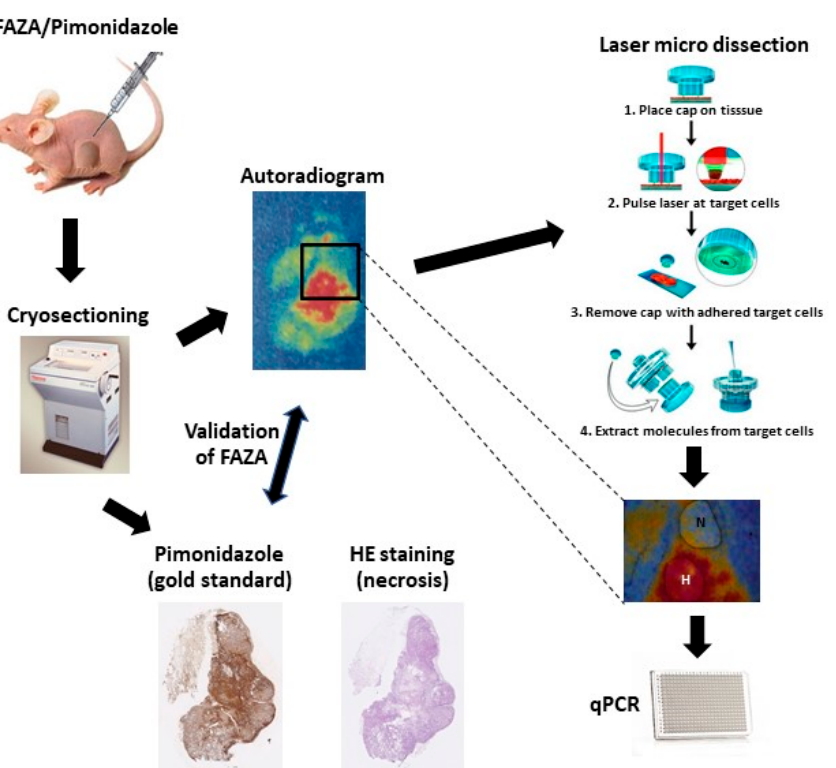
Figure 1. Illustration of the set-up for the in vivo experiment. A nude mouse with a xenograft prostate tumor growing on the flank was intraperitoneally injected with both FAZA and pimonidazole. Approximately four hours later, the mouse was sacrificed, and the tumor was excised and fresh frozen. The tumor was immediately cryo-sectioned in three layers, each layer consisting of 10 consecutive 10 µ m sections. Then, these sections were stained for either hematoxylin and eosin (HE) or pimonidazole binding, or used for FAZA autoradiography. The autoradiogram was used as a template for laser micro dissection, where the hypoxic (H) and the non-hypoxic (NH) areas were identified and cut. HE staining was used to evaluate and avoid necrotic areas. This dissected tissue was immediately lysed and real-time PCR (qPCR) performed. The images of the laser micro dissection technique are from Arcturus Bioscience (Mountain View, CA, USA).